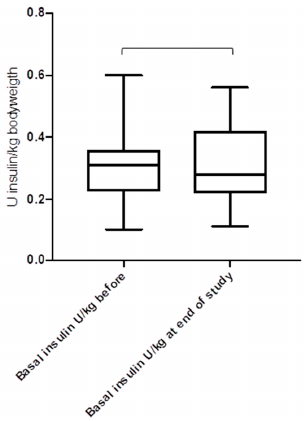
Figure 5. Basal insulin dose before and after the introduction of CSII and CGM ( n = 41) ( p = 0.41).